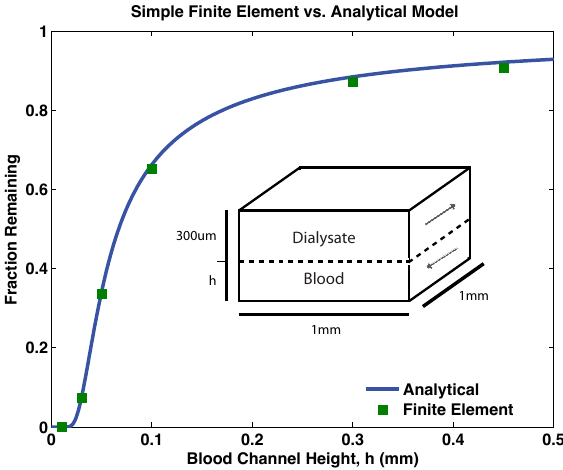
Figure 3. A comparison between the analytical model and a simple finite element model incorporating ideal geometry (schematic inset). Though the analytical model is one-dimensional and the finite element model is three-dimensional, they are in near-exact agreement regardless of blood channel height. These data for a solute of hydrodynamic radius 1.5 nanometers and a blood flow rate of 10 millimeters per